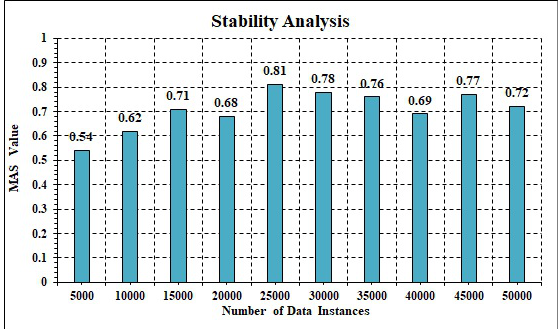
Figure 8. Overall System